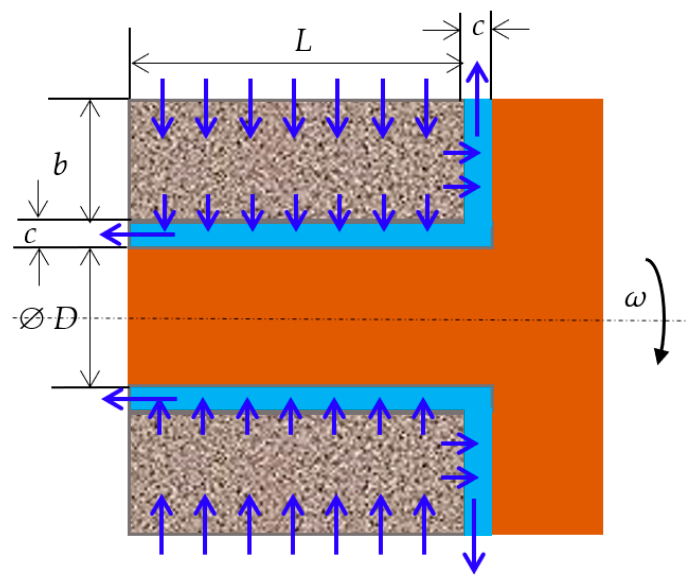
Figure 2. Annular-thrust porous aerostatic bearing.